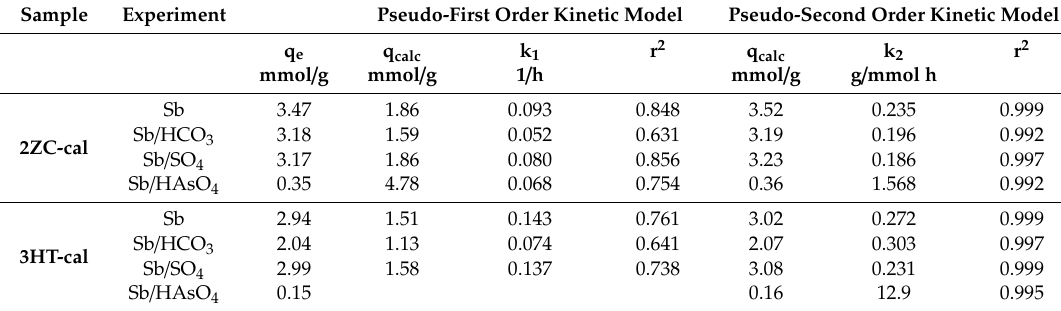
Table 4. The Sb(OH) 6 − sorption capacity of 2ZC-cal and 3HT-cal determined at equilibrium from the experimental data (q e ) and calculated from the kinetic models (q calc ).